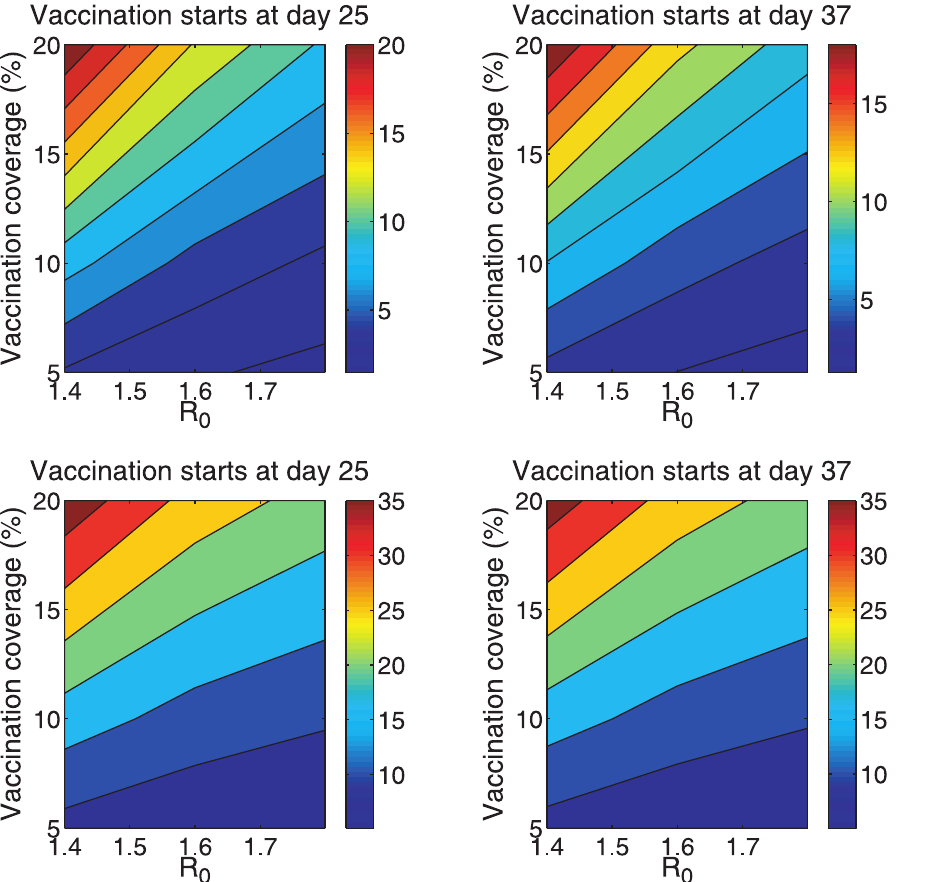
Figure 4. Comparison of concurrent vaccination strategies for novel S-OIV pandemic influenza scenarios. Strategies include adaptive vaccination targeted at high-risk groups identified from real-time hospitalization and death data, and seasonal vaccination strategy targeted at young children and seniors. Plots illustrate the additional reduction (%, see color bar) in hospitalizations (top) and deaths (bottom) averted by the adaptive vaccination allocation strategy, compared to the seasonal influenza strategy, as a function of R (using plausible ranges, R=1.4–1.8) and vaccination coverage (5–20%). In the left panels, vaccination is initiated 25 days into the outbreak, on April-17-2009, when the epidemiologic alert was issued. In the right panels, vaccination is initiated 37 days into the outbreak, on Apr-29-2009, when selective reporting of severe pneumonia cases ceased. The adaptive strategy allocates vaccine given the age-specific patterns of hospitalization and mortality available on those dates (Figure 2).